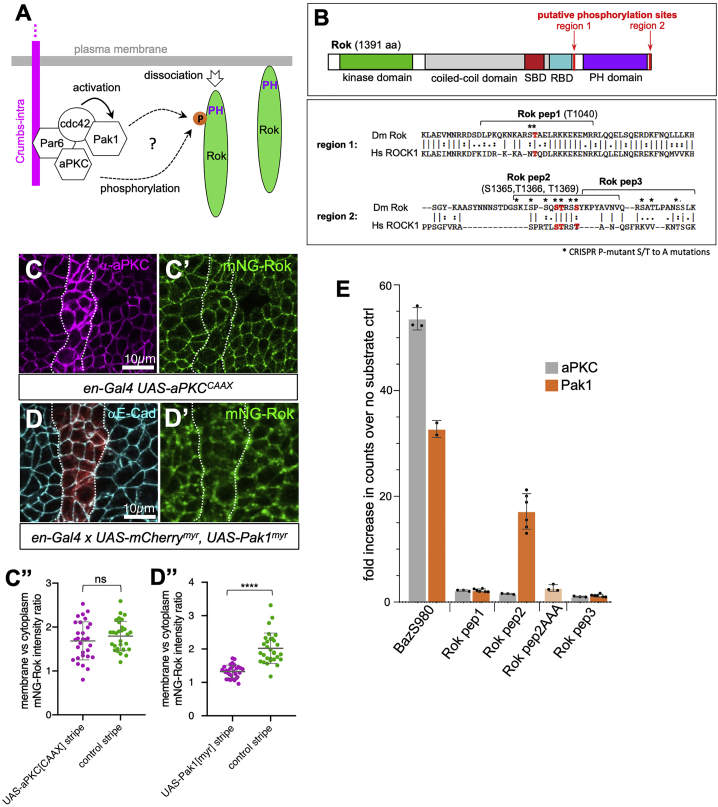
Pak1 Can Phosphorylate Rok and Induce Its Dissociation from the Membrane(A) Crumbs’ intracellular tail can interact with two kinases with highly overlapping phosphorylation targets: aPKC and Pak1.(B) Both aPKC and Pak1 have many overlapping predicted phosphorylation sites in Rok, in particular near the C-terminal RBD and PH domains. Residues marked in red and named above the sequence are conserved between Dm Rok and Hs ROCK1 and are phosphorylated in human EpH4 cells (Ishiuchi and Takeichi, 2011). Residues marked by asterisks were mutated in mNG-Rok[Pmut], see Figure 6. Phosphorylation of Rok by either or both kinases could promote its dissociation from the plasma membrane (A). See also Figure S4.(C–C″) Overexpression in stripes of a membrane-targeted version of aPKC (magenta in (C), en-Gal4 UAS-aPKC[CAAX]) does not significantly affect membrane localization of mNG-Rok (green) in the overexpressing stripes, quantified in (C″). Data are represented as data points, mean, and SEM. Unpaired t test was used to determine statistical significance; p value is 0.278 (ns).(D–D″) Overexpression in stripes of a membrane-targeted version of Pak1 (red marks overexpression stripe in (D); en-Gal4 x UAS-mCherry, UAS-Pak1myr) leads to a loss of mNG-Rok (green) from the membrane in the overexpressing stripes, as quantified in (D″). Data are represented as data points, mean, and SEM. Unpaired t test was used to determine statistical significance; p value is <0.0001 (∗∗∗∗).(E) Using purified kinase domains of either aPKC or Pak1 and short peptide substrates of Rok (indicated in B) in an in vitro kinase assay, we can detect phosphorylation of Rok peptide 2 (Rok pep2), which is located near the PH domain, by Pak1 but no phosphorylation of any Rok peptide tested by aPKC. Both kinase domains phosphorylate a known substrate peptide from Bazooka (BazS980). Data show fold enrichment of radioactive P(33)-phosphate counts over “no substrate” control; data points, mean, and SEM are shown. Rok pep2AAA is identical to the Rok pep2 peptide, with three potential phosphorylation sites mutated to alanine: S1365A, T1366A, and T1369A.See also Figure S4.